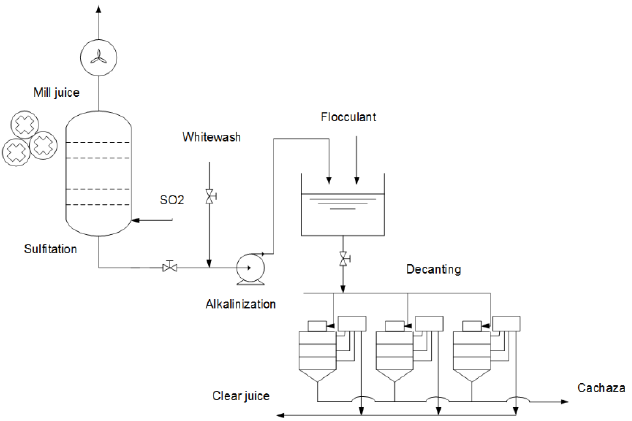
Figure 5. Sugar cane juice treatment scheme.